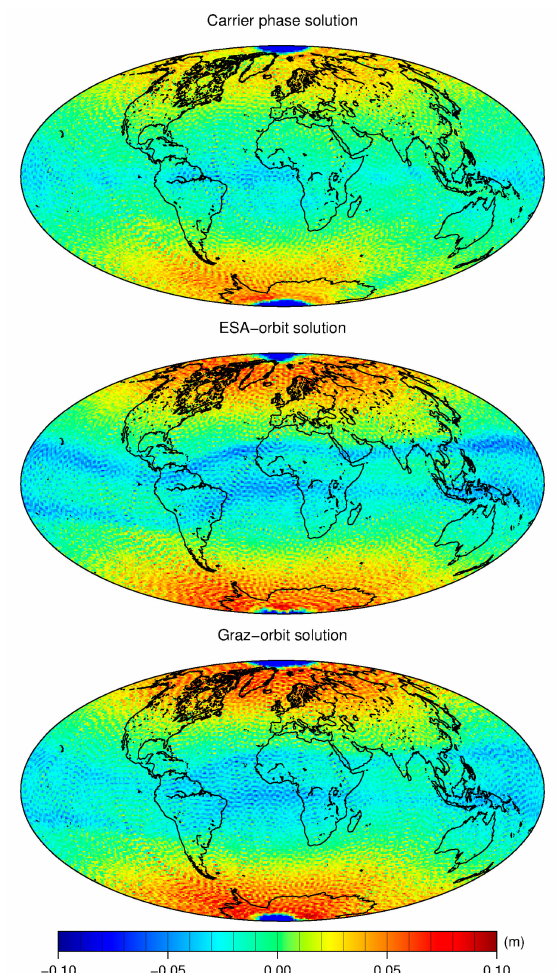
Figure 7. Geoid height errors of the recovered spherical harmonic coe ffi cients w.r.t. DGM-1S with the 500 km Gaussian smoothing